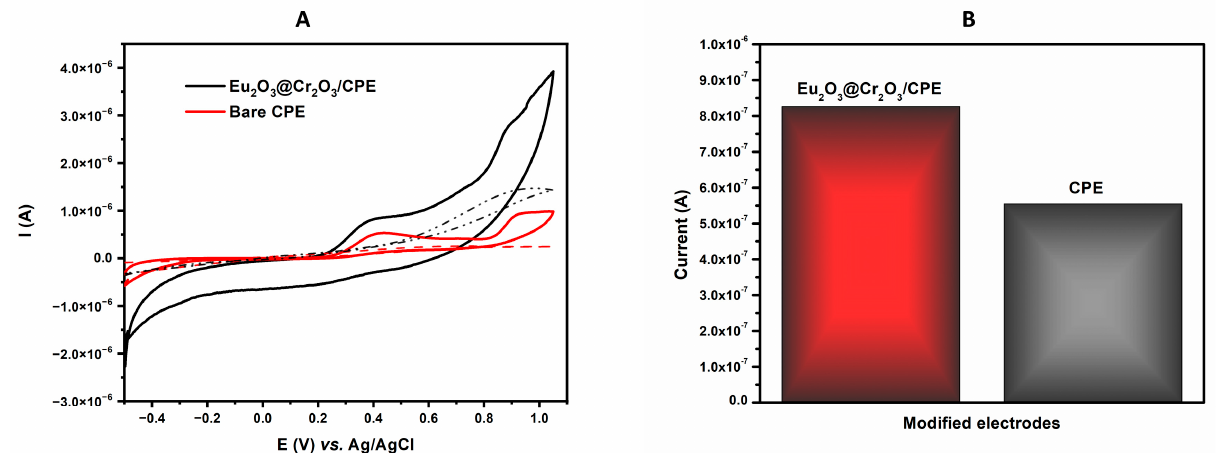
Figure 3. ( A ) CV current response for bare CPE and Eu 2 O 3 @Cr 2 O 3 /CPE, pH 7.0 (BRBS) without (dotted line) and with 100 µ M L-DOPA (solid line) at a scan rate of 0.05 V s − 1 . ( B ) The corresponding bar graph for anodic peak current response for L-DOPA over bare and modified CPE.